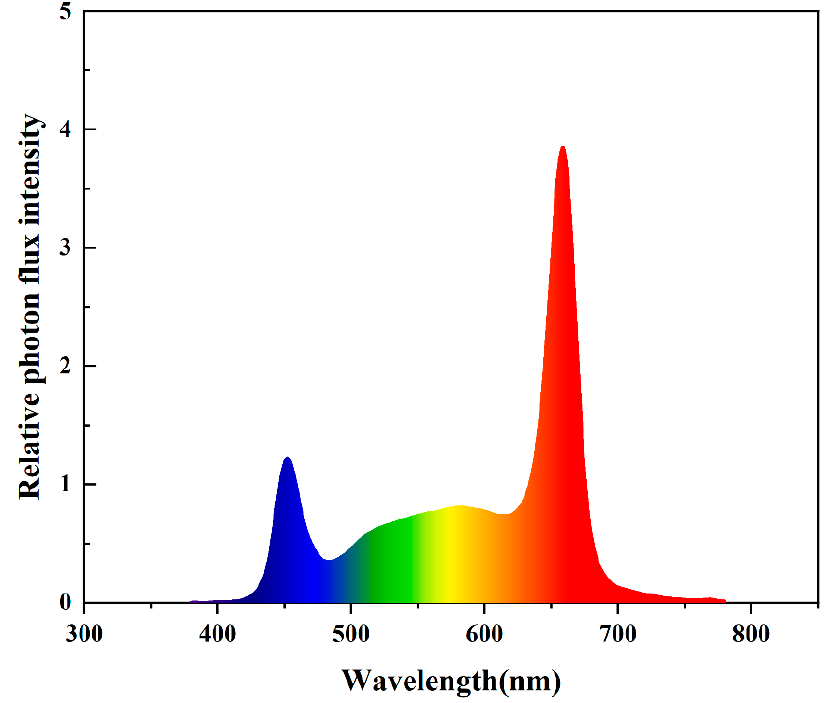
Figure 1. Spectral composition in this study. Different colors represent different wavelengths of light.